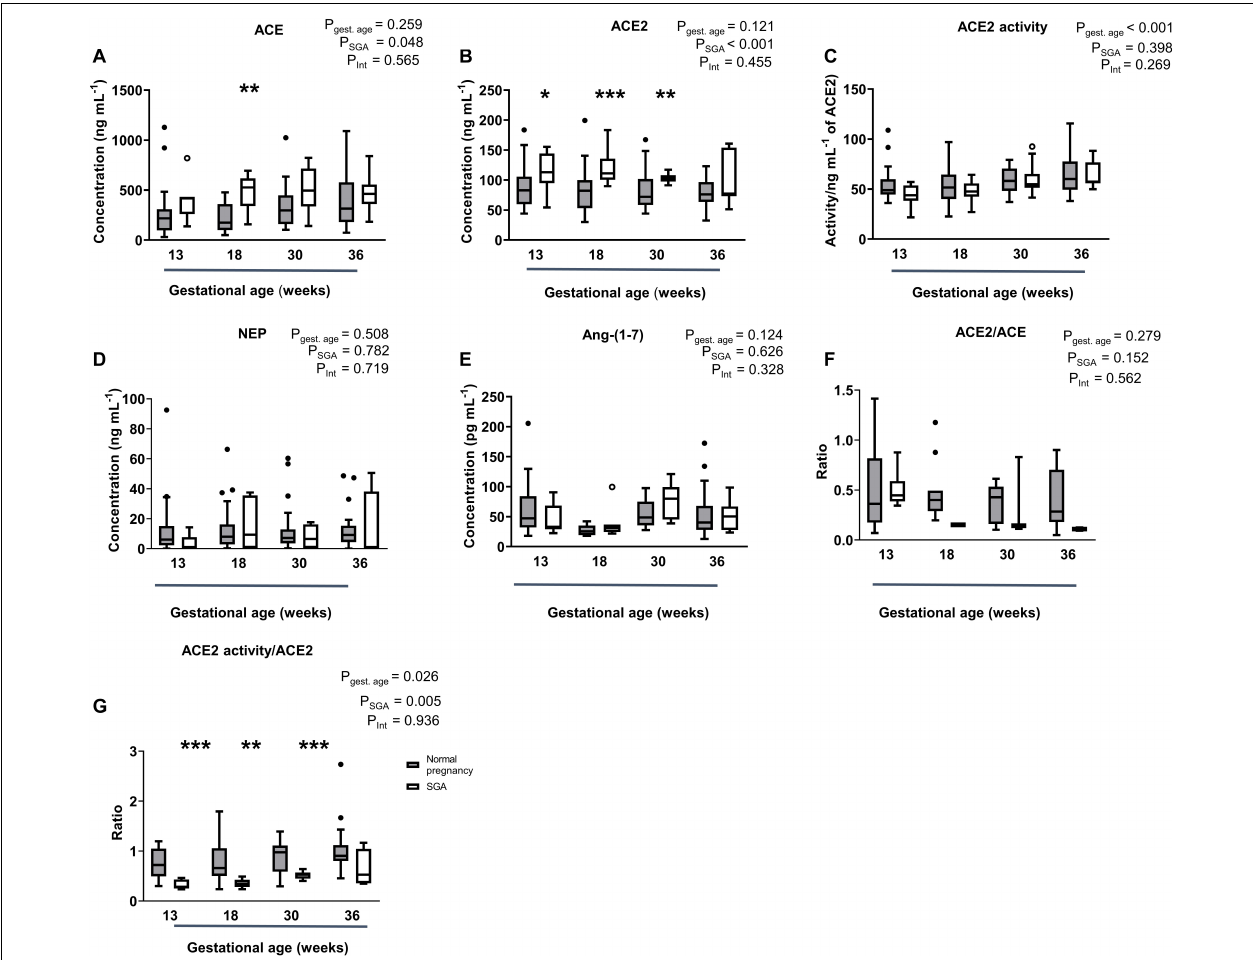
FIGURE 4 | Plasma levels and activity of (A) ACE, (B,C) ACE 2 , and (D) NEP as well as levels of (E) Ang-(1-7), (F) ACE2/ACE ratio, and (G) ACE2 activity/ACE2 ratio in normal and SGA pregnancies. Data are expressed as median and interquartile range. n = 5–36 samples/group for normal pregnancies (gray box) and n = 4–15 samples/group for SGA pregnancies (white box). P -values were calculated using a two-way ANOVA (mixed effect model with Fisher’s LSD multiple comparison test). ∗ P < 0.05, ∗∗ P < 0.01, ∗∗∗ P < 0.001 versus normal pregnancy group of the same gestational